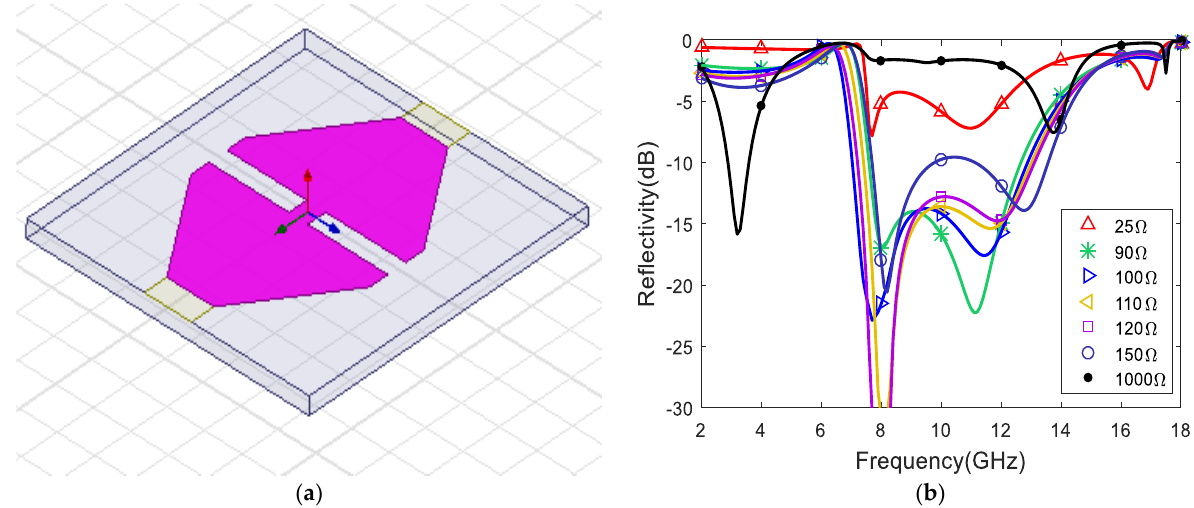
Figure 1. AFSS structure simulation. ( a ) HFSS model. ( b ) Reflectivity results in different resistance.